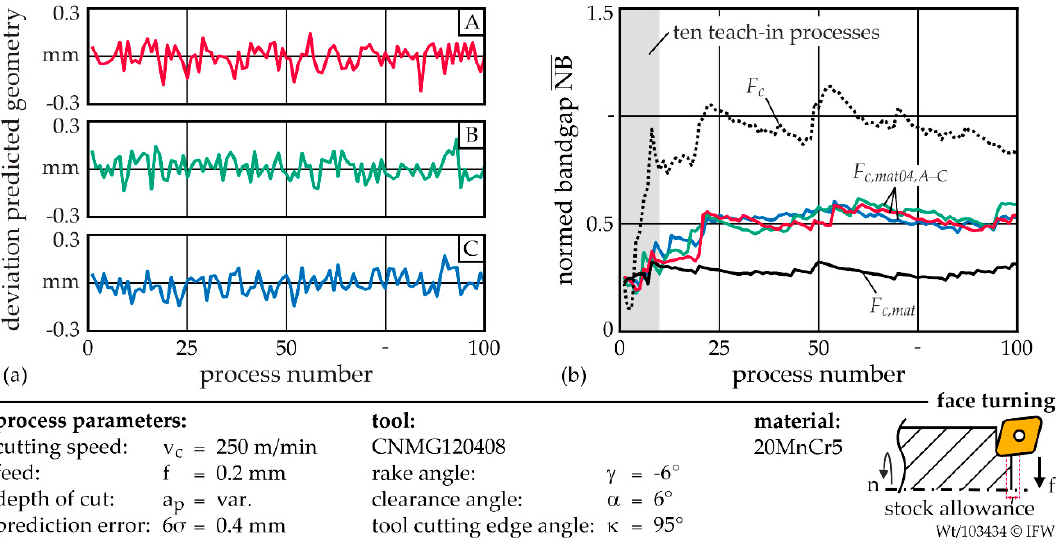
Figure 5. ( a ) Distribution of three process series with different deviation of the predicted geometry and ( b ) evolution of normed bandgaps for one hundred facing operations per series for stock allowance variation A.